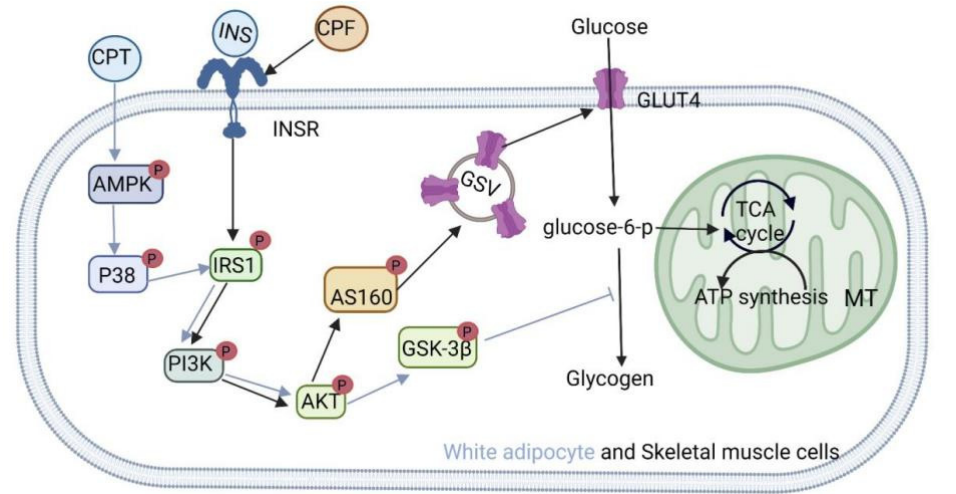
Figure 5. The mechanism of action of Cyclocarya paliurus extract with respect to inhibiting pathological insulin resistance in white adipocytes and muscle cells.